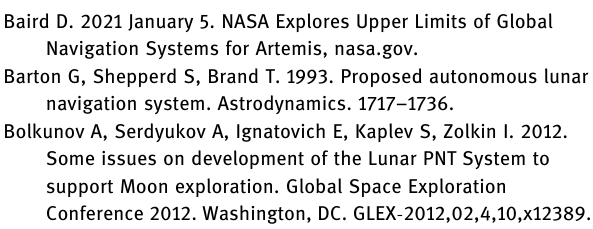
Figure 14: Rover positioning